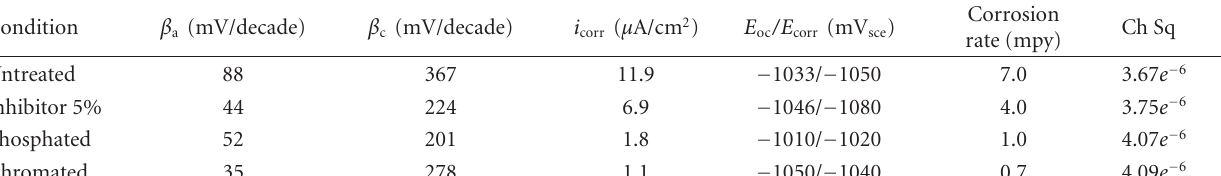
Table 2: Electrochemical data of the tested materials after immersion in 0.5 M NaCl for 1h.